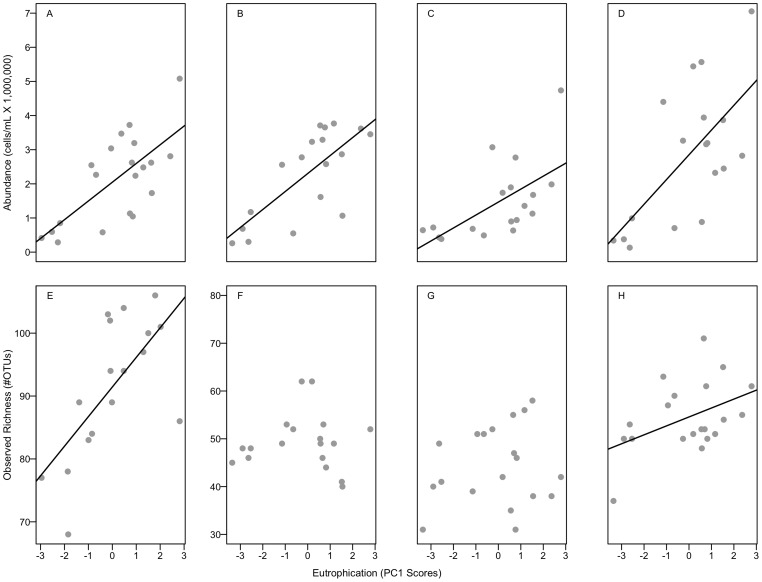
Relationships of increasing trophic state (PC 1 scores) with abundance and richness.A) Whole-lake average abundance (R2 = 0.46, p<0.001), B) Epilimnetic abundance (R2 = 0.52, p<0.001), C) Metalimnetic abundance (R2 = 0.33, p = 0.007), D) Hypolimnetic abundance (R2 = 0.40, p = 0.003), E) Whole-lake average richness (R2 = 0.30, p = 0.003), F) Epilimnetic richness (R2 = −0.06, p = 0.98), G) Metalimnetic richness (R2 = −0.03, p = 0.49), and H) Hypolimnetic richness (R2 = 0.15, p = 0.05).